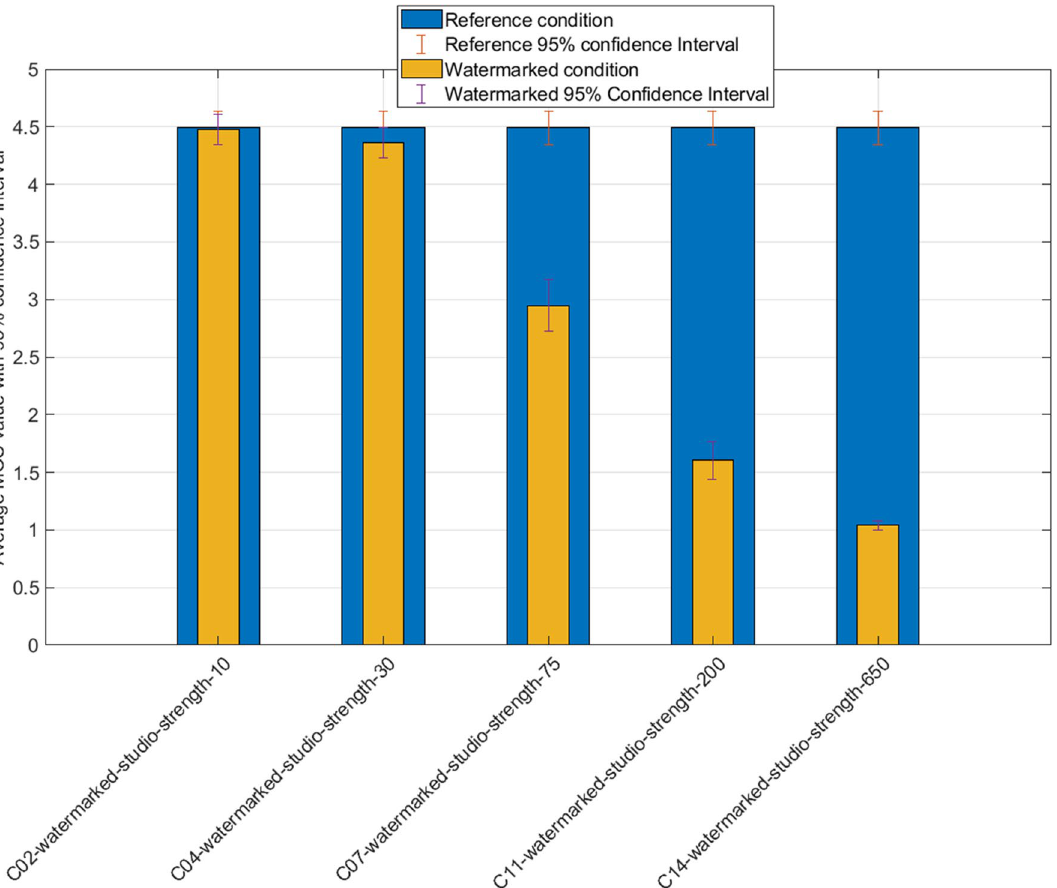
Figure 2. Results of reference studio condition with increasing watermark strength.